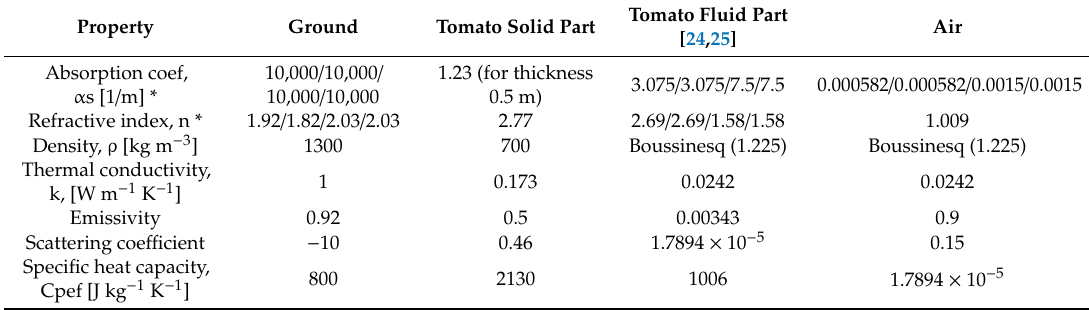
Table 6. Thermal and optical properties of the rest greenhouse materials considered in the